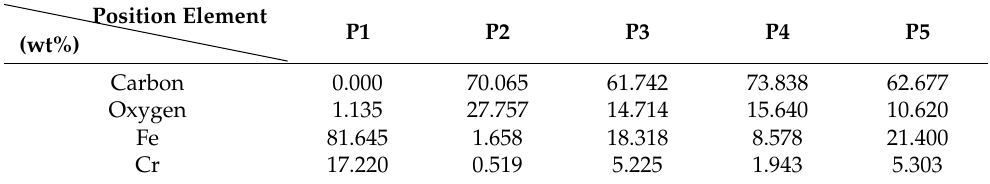
Table 4. Chemical compositions (wt%) of representative elements of the analysis points in Figure 10a.